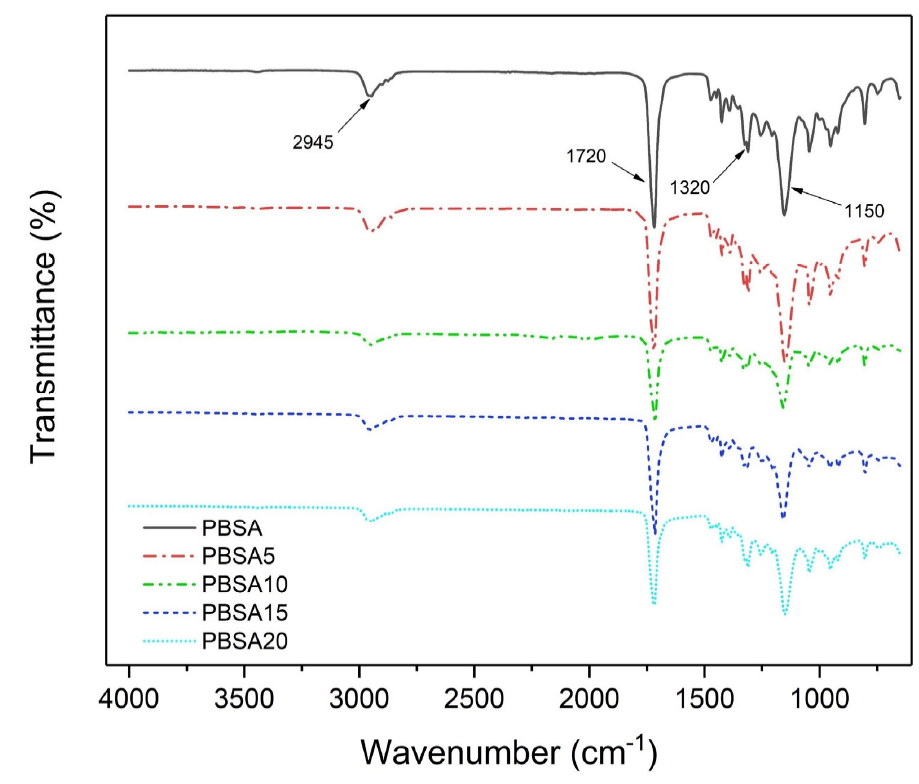
Figure 4. FTIR spectrum of neat PBSA and PBSA/BC composites.